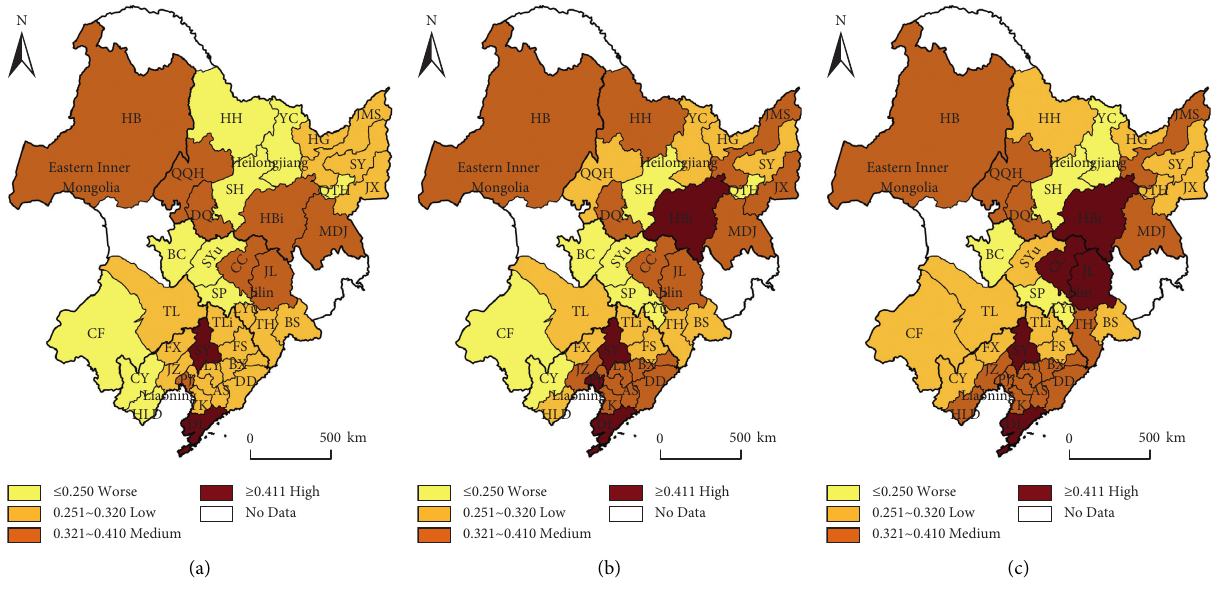
Figure 2: Map of distributions of urban economic resilience in Northeast China in 2005, 2010, and